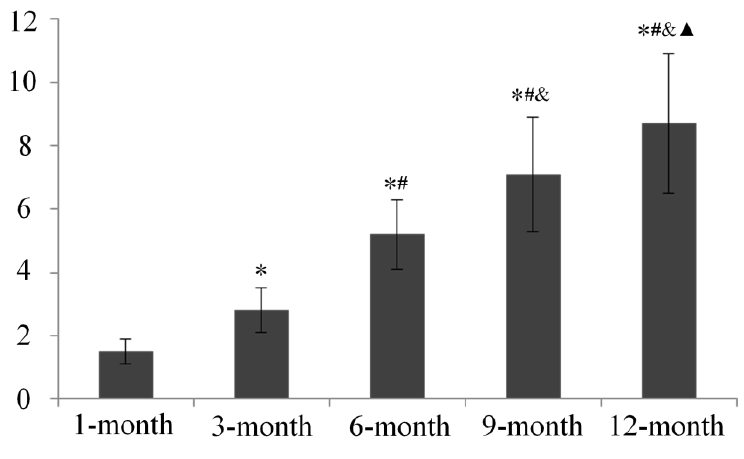
Figure 3. Mankin score of the articular cartilage in each age group. * p < 0.05, compared with 1-month group; # p < 0.05, compared with 3-month group; & p < 0.05, compared with 6- month group; ▲ p < 0.05, compared with 9-month group.